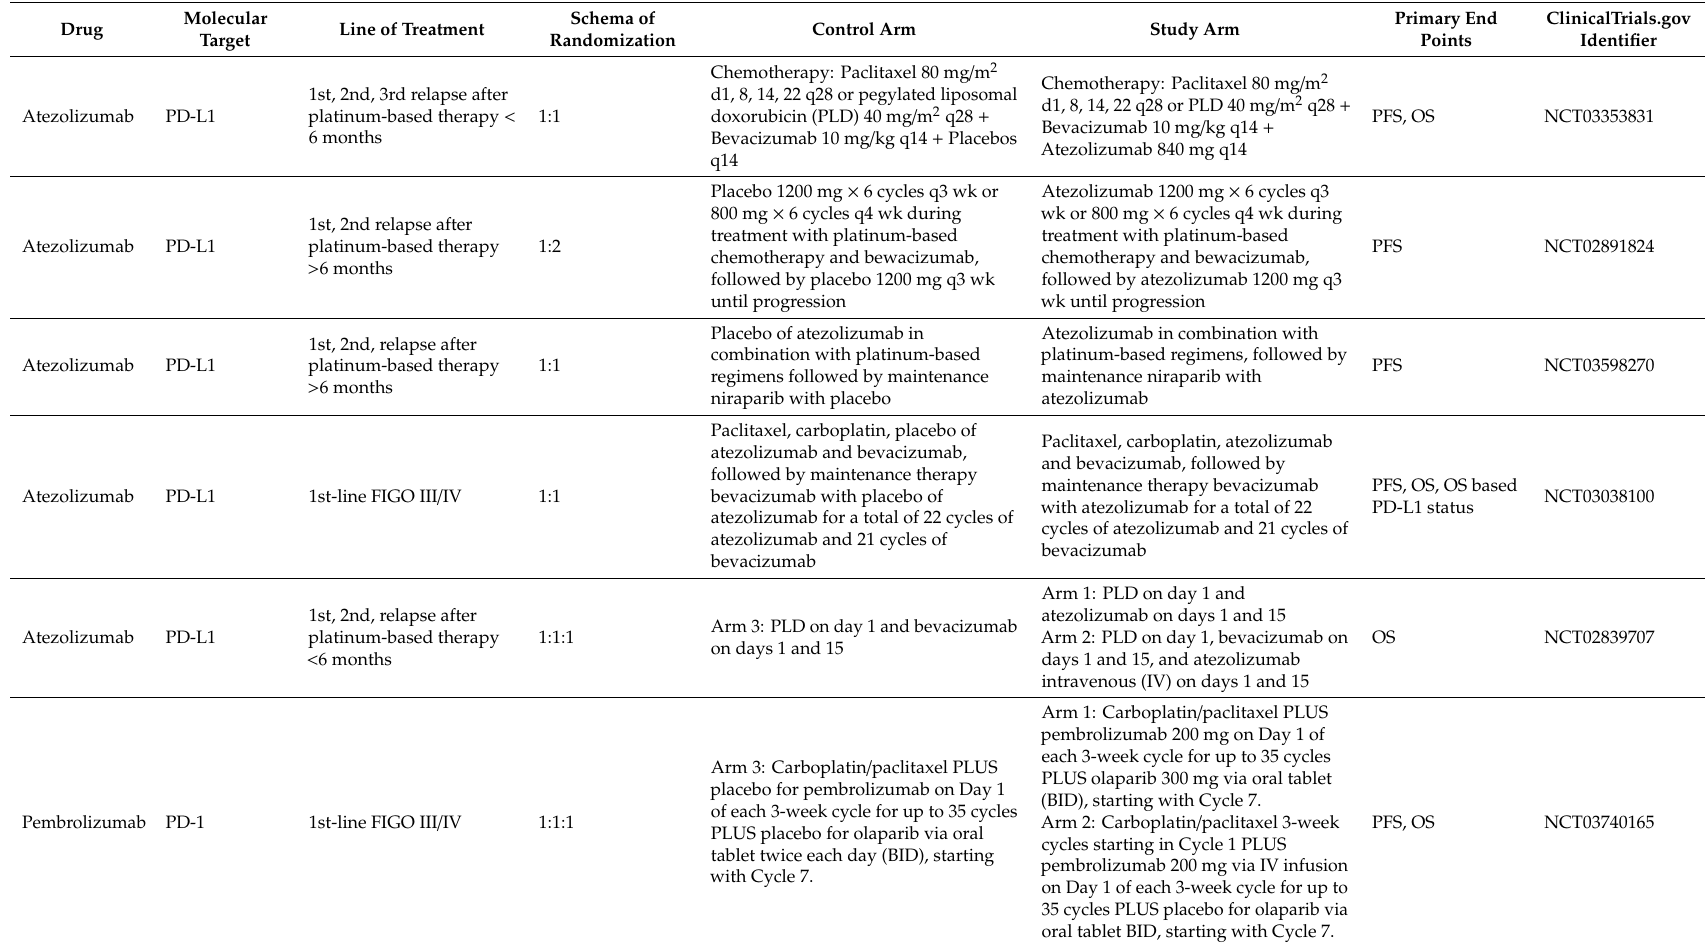
Table 3. Immune checkpoint inhibitors in ongoing phase III clinical trials for ovarian